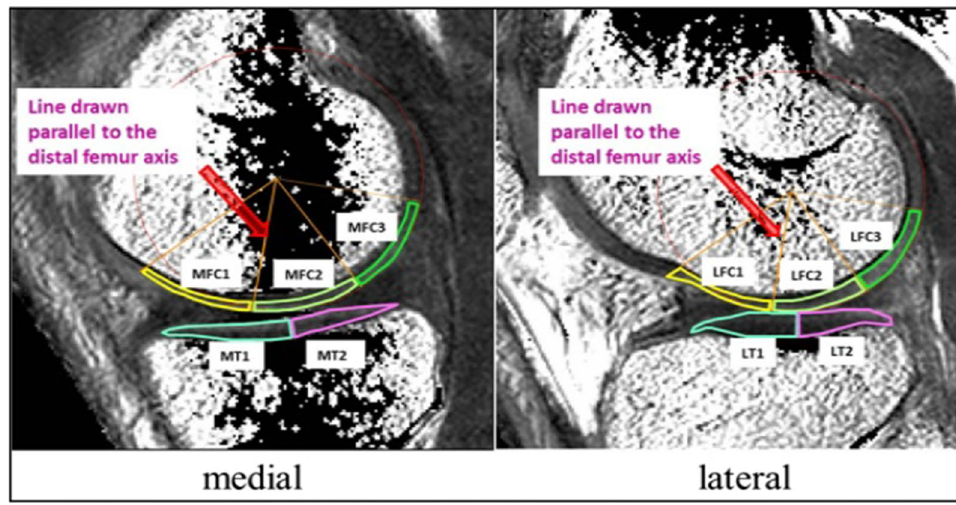
Fig. 1 Compartmentalization according to the whole organ magnetic resonance imaging score (WORMS) of the knee in osteoarthritis. Each region of interest (ROI) was defined as follows: ROIs on the femoral articular cartilage were divided into an anterior area 45° from the line (MFC1, LFC1), a middle area 45° posterior from the line (MFC2, LFC2), and a posterior area 45° to 90° posterior from the line (MFC3, LFC3). ROIs on the tibial articular cartilage were divided into an anterior (MT1, LT1) and posterior area (MT2, LT2). Left: medial compartment. Right: lateral compartment. MFC medial femoral condyle, MT medial tibia, LFC lateral femoral condyle, LT lateral tibia (Quoted from Proffen et al.